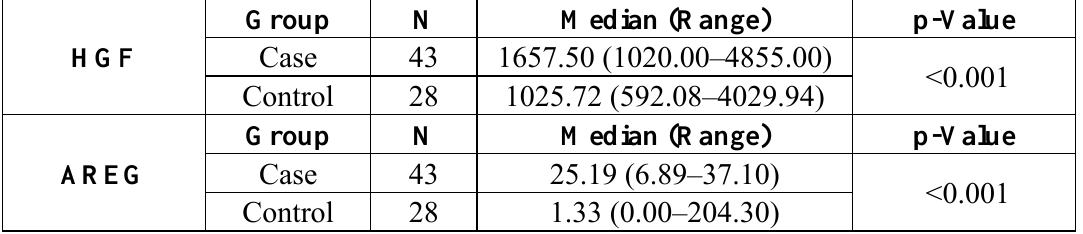
Table 2. HGF and AREG serum levels in cases and controls.